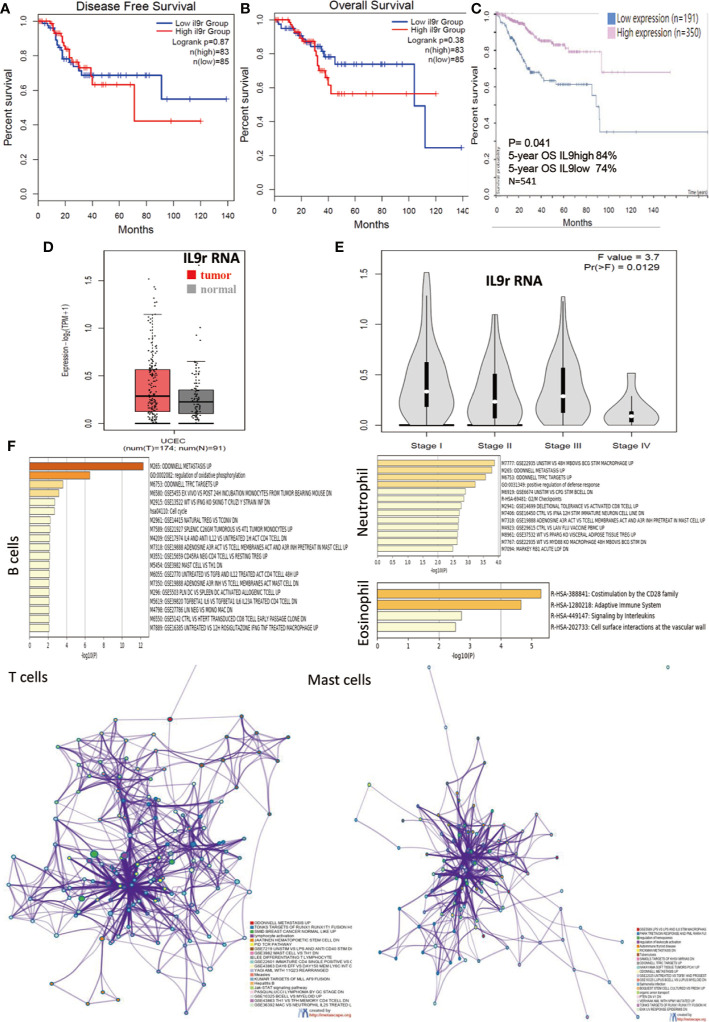
Pathway and Process Enrichment Analysis of IL9R. (A, B) Disease-free survival and overall survival analysis based on the expression status of IL9R RNA and a Kaplan–Meier curve was plotted. (n = 168) (C) Overall survival analysis based on the expression status of IL9R RNA and a Kaplan–Meier curve was plotted (n = 541). (D) The expression of IL9R RNA in tumor and adjacent normal tissue UCEC by analyzing TCGA dataset. UCEC, Uterine Corpus Endometrial Carcinoma (n = 265, p < 0.05). (E) The expression of IL9R RNA in stages I–IV UCEC by analyzing TCGA dataset. UCEC, Uterine Corpus Endometrial Carcinoma. (F) Pathway and process enrichment analysis of IL9R related genes had been carried out in different cell types with the following ontology sources: KEGG Pathway, GO Biological Processes, Reactome Gene Sets, Canonical Pathways, and CORUM. Top 20 clusters with their enriched representative terms were shown here. A subset of enriched terms of T cells and mast cells had been selected and rendered as a network plot of IL9R, where terms with a similarity >0.3 were connected by edges. The network was visualized using Cytoscape, where each node represented an enriched term.